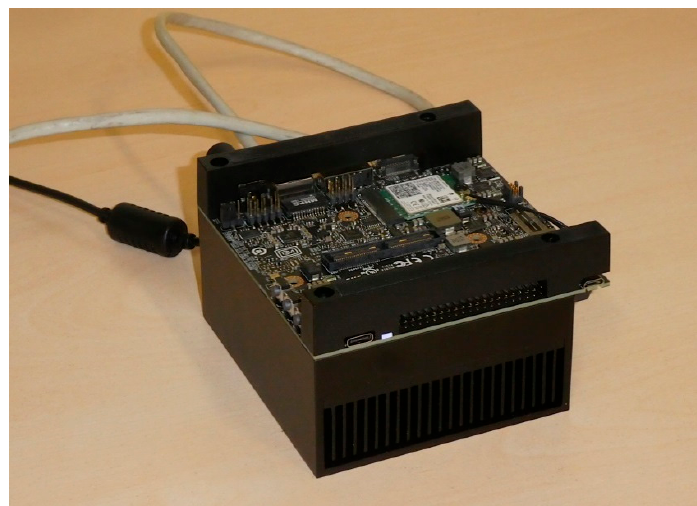
Figure 2. An embedded single board computer for the beehive location.